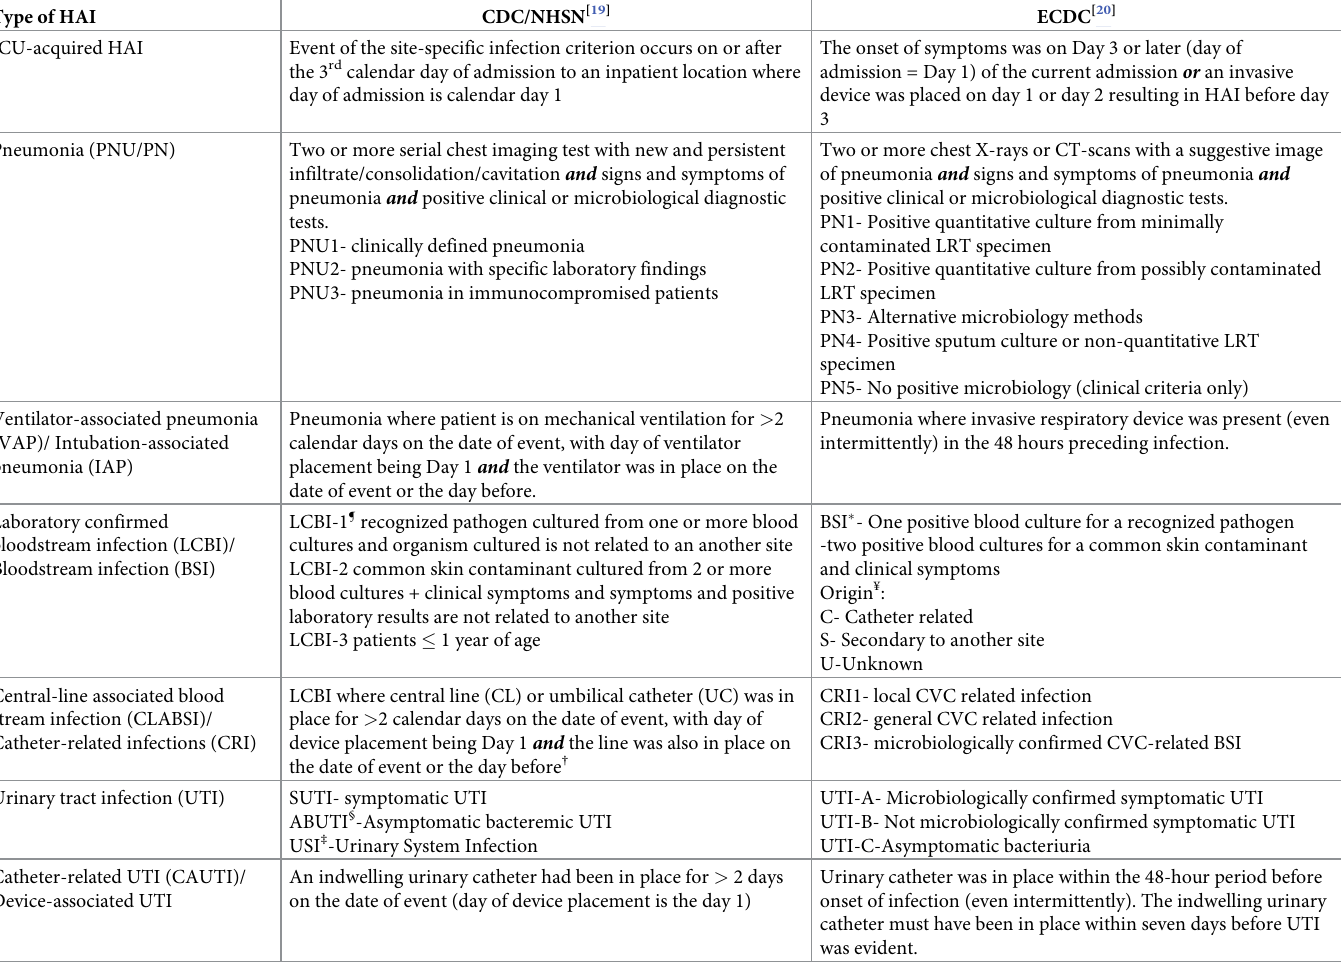
Table 2. HAI definitions according to CDC/NHSN and ECDC